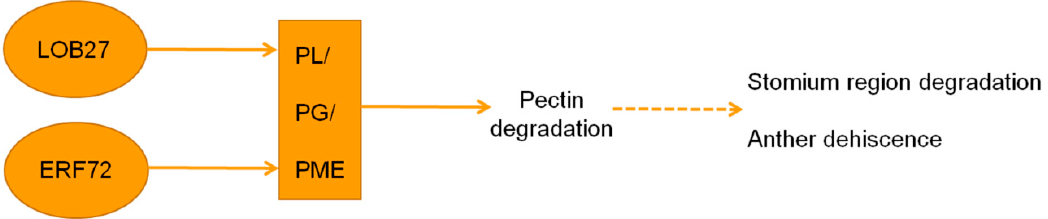
Figure 10. A model of LOB27 and ERF72, which regulate pectin degradation. The dashed arrows indicate positive regulation.